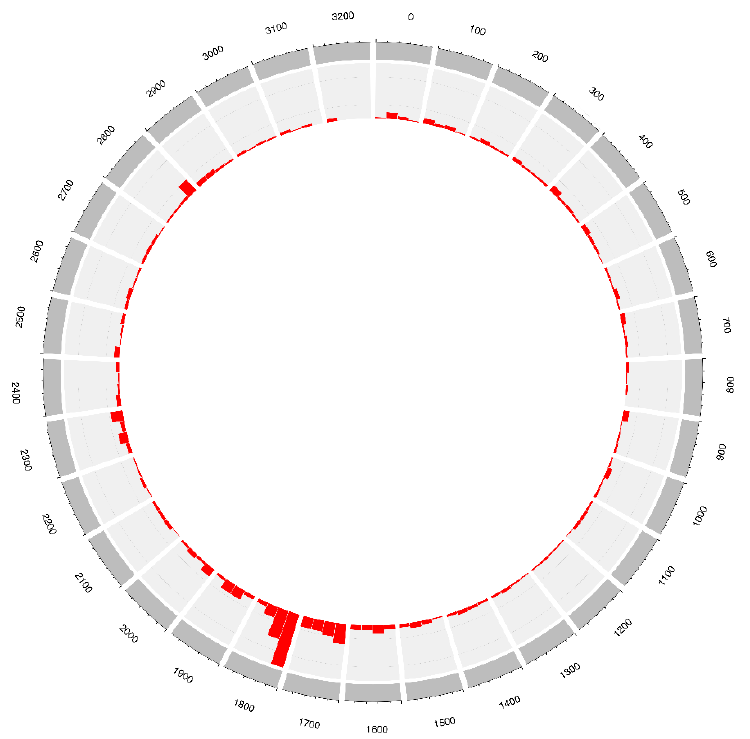
Figure 2. Distribution of integration breakpoints in the HBV genome in HCC tumor samples. A total of 3052 HBV breakpoints were plotted. The histogram represents the frequency of integration breakpoints at different loci in the HBV genome (nt. 1–3215; bin size 25) as numbered in the outer ring.